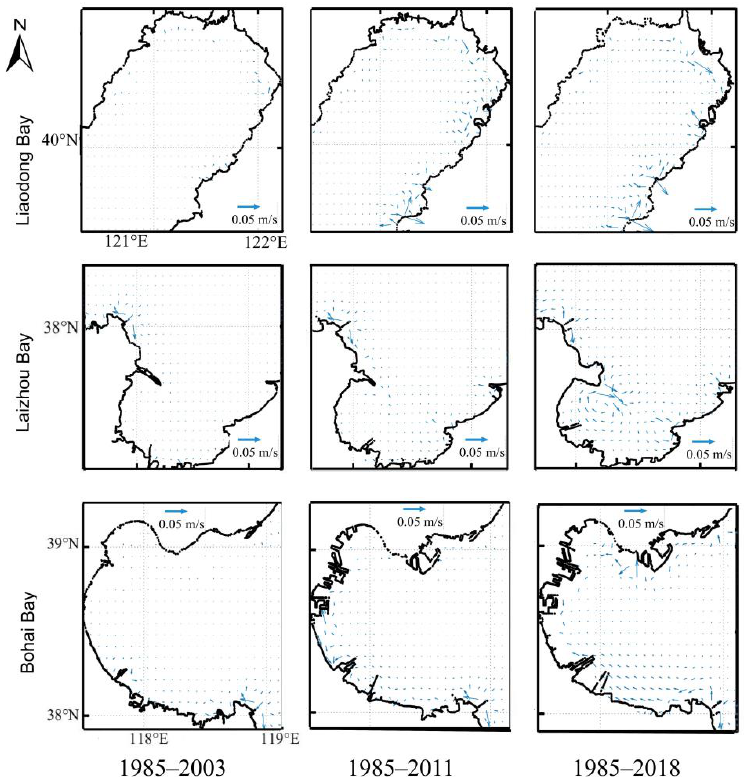
Figure 12. The differences in residual current among three periods. Arrows denote the speeds, and their lengths were determined by the magnitude of the residual velocity.